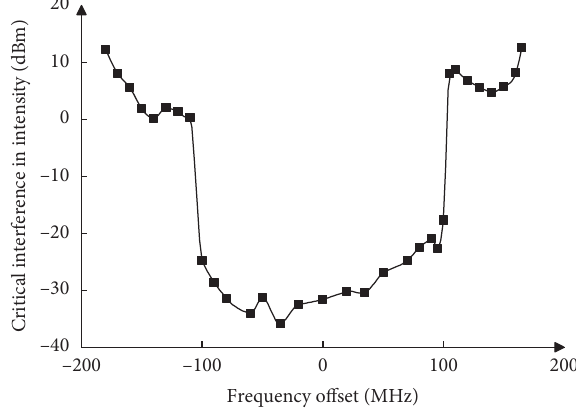
Figure 4: Single-frequency susceptibility of the radar under test.